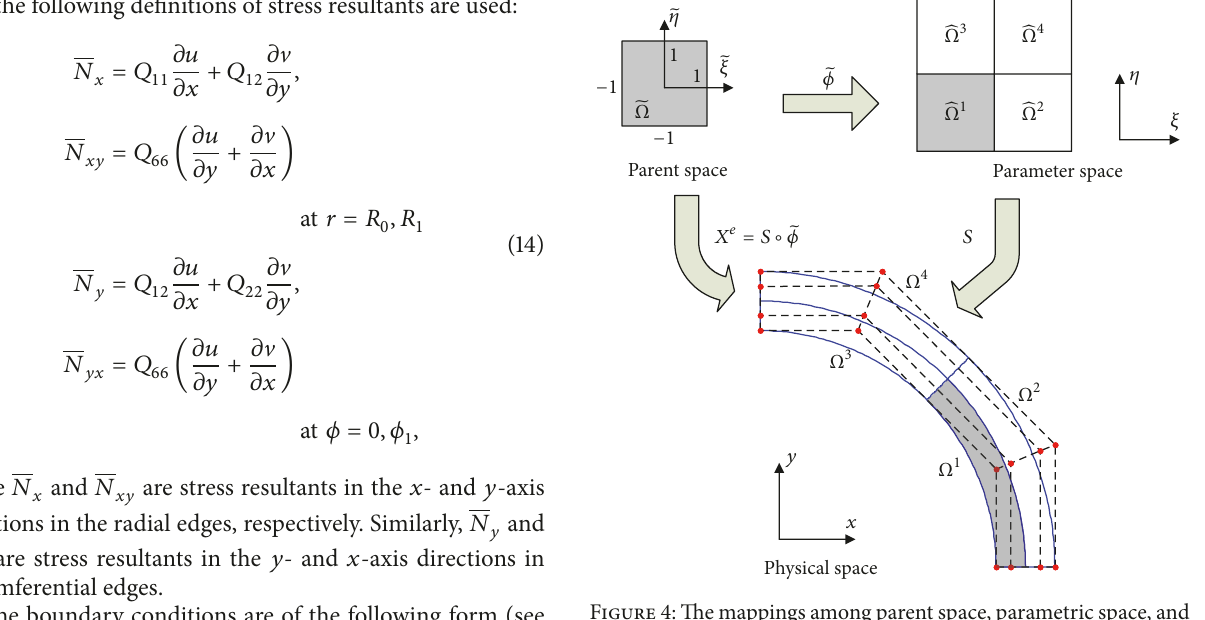
control points. From Figure 2, there are six control